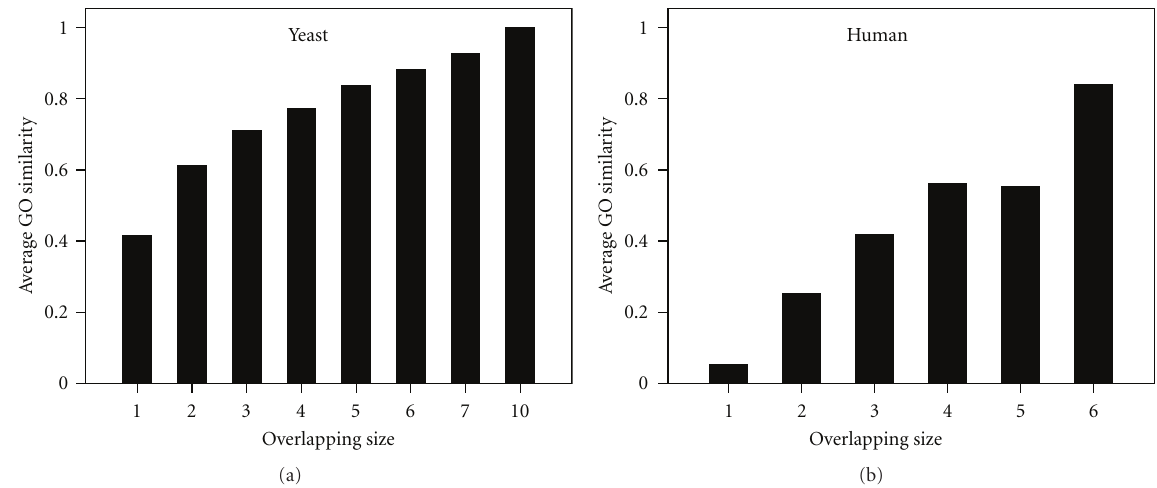
Figure 7: Modules with larger overlapping size confer more similar GO annotation. The x -axis represents the overlapping size. The y -axis is the mean value of GO similarity. (a) Yeast PPI network. (b) Human PPI